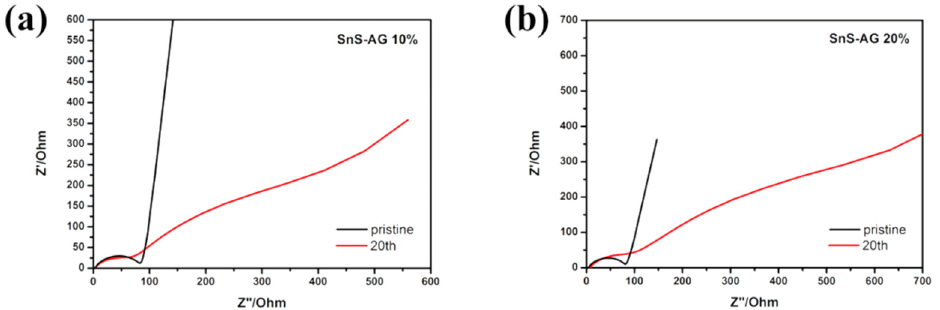
Figure 9. Electron impedance spectroscopy (EIS) diagrams for ( a ) 10SnS/AG and ( b ) 20SnS/AG, before and after 20 cycles.